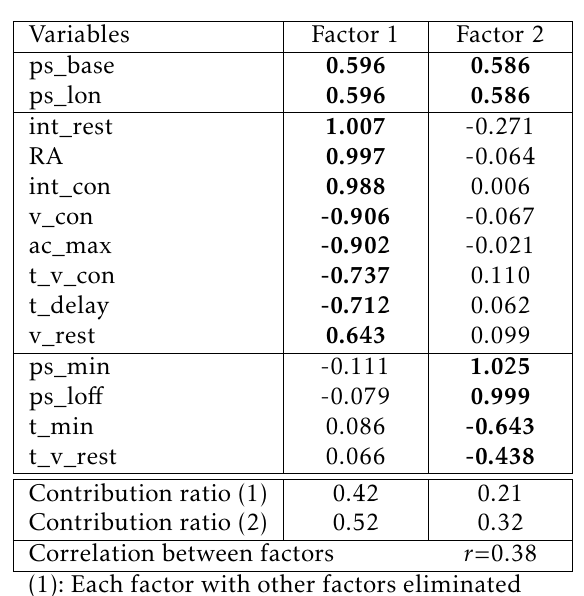
Table 4. Factor loading matrix for PLR features with Promax